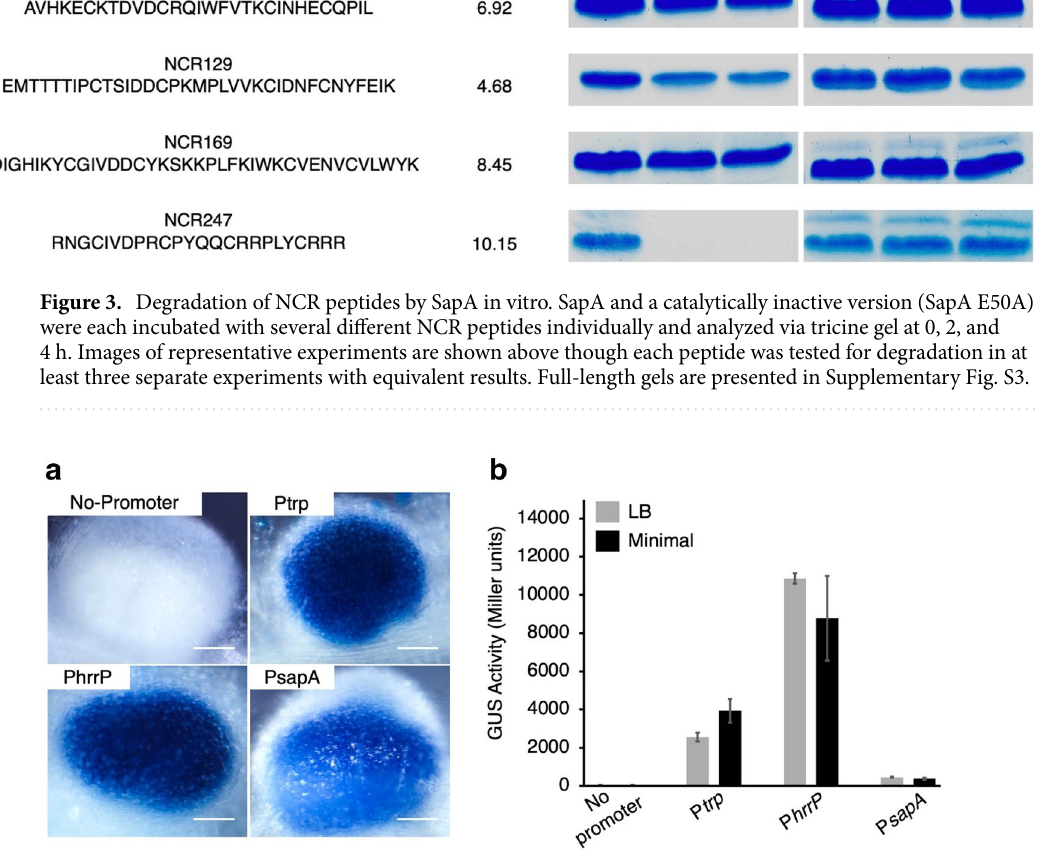
Figure 4. Expression pattern of sapA in vivo and in vitro. Promoter- gus fusion strains were made to determine if the promoter for sapA is active in nodules ( a ) or in free-living cells ( b ). In ( a ), nodules were harvested 7 dpi and stained for GUS activity. Scale bars are 100 μm. In ( b ), Miller assays were performed on three biological replicates of each condition. Error bars correspond to 95% confidence